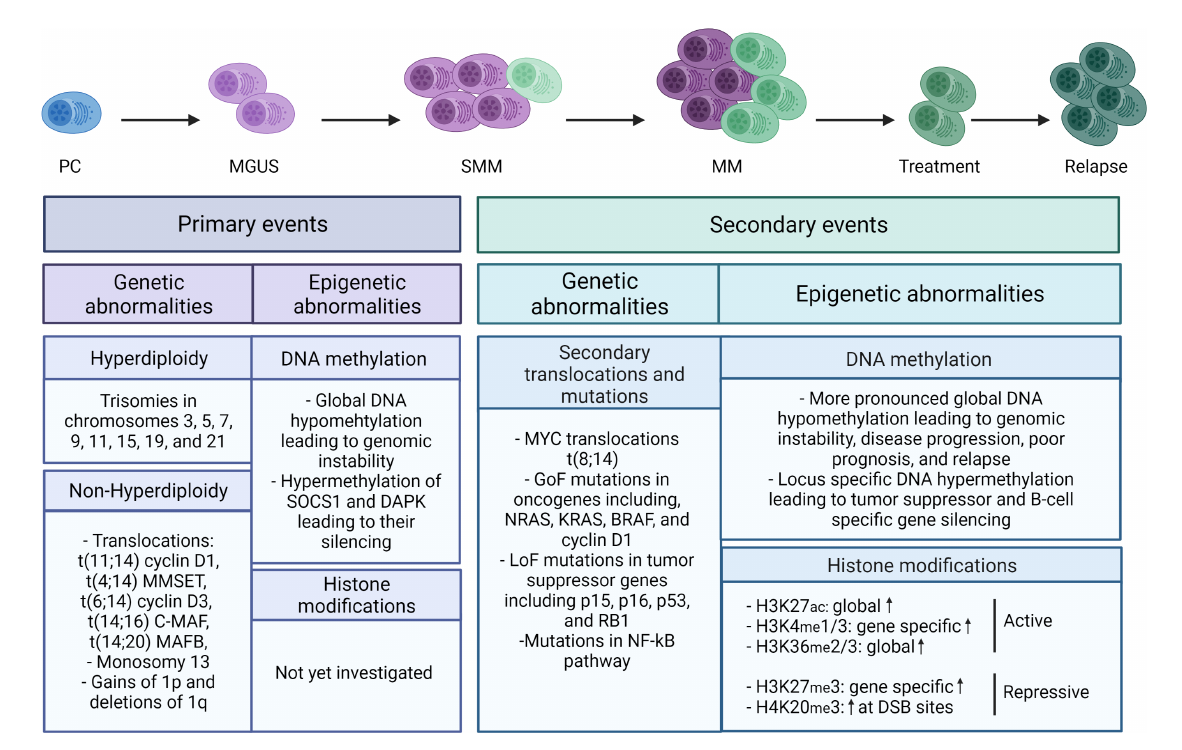
FIGURE 1 Schematic overview of the genetic and epigenetic abnormalities in MM. Primary (epi)genetic events are driving MM onset, while the secondary events are fostering MM progression and relapse. Primary genetic events include both hyperdiploid and non-hyperdiploid abnormalities, while primary epigenetic events are mainly characterized by global DNA hypomethylation and promotor speci fi c hypermethylation of the tumor suppressors SOCS1 and DAPK. Secondary genetic events include non-recurrent secondary translocations, gain-of-function (GoF) mutations in oncogenes, and loss-of-function (LoF) mutations in tumor suppressor genes, while on the epigenetic level more pronounced global DNA hypomethylation and locus speci fi c hypermethylation are observed together with increased (both global and locus speci fi c) histone mark levels, including H3K27Ac, H3K4me1/3, H3K36me2/3, H3K27me3, and H4K20me3. The blue cell represents a normal plasma cell, while the purple and green cells represent respectively MM cells with primary and secondary events. The color gradation represents the increase in abnormalities in each stage. DSB, double strand